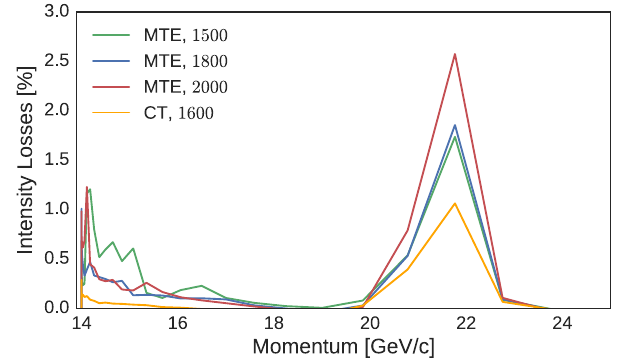
FIG. 17. Intensity losses in % as a function of momentum for 2015 data, both CTand MTE. The highest intensity losses (for all four time frames) come around 22 GeV = c, corresponding to transition crossing, reaching as high as 2.5%. The typical intensity values are in units of 10 10 ppp at extraction from the